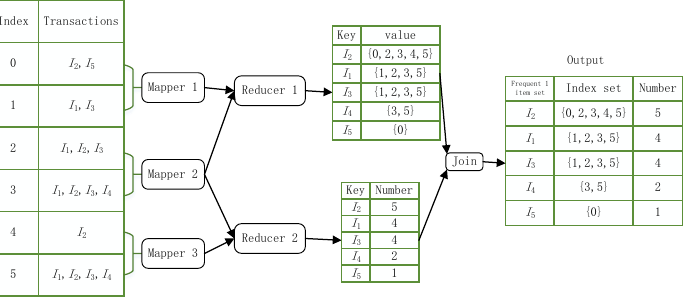
Figure 8. Constructing frequent 1-item